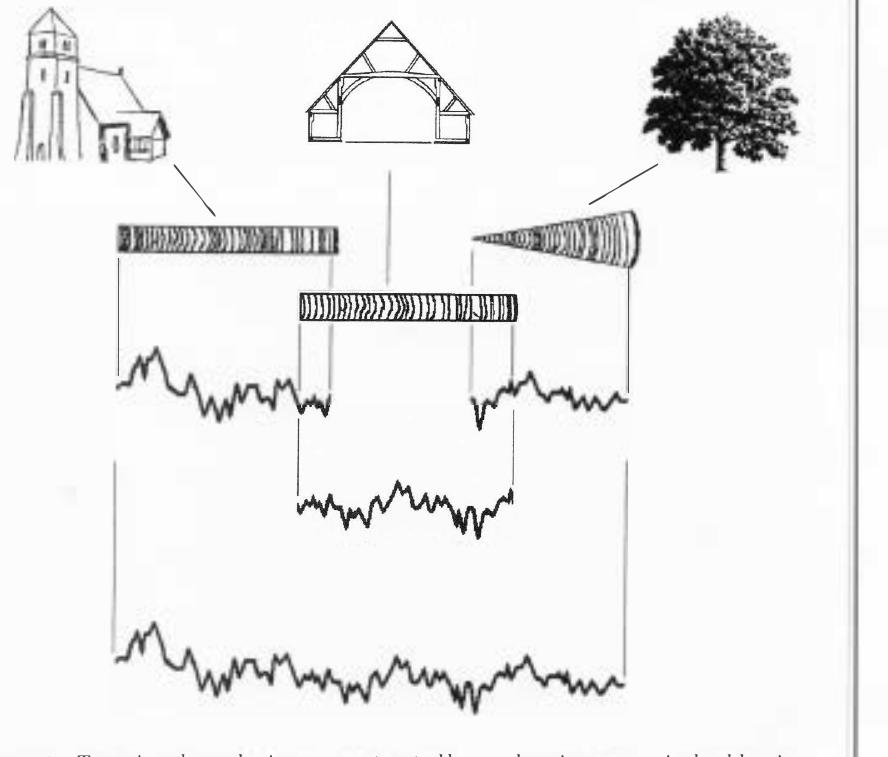
Figure 1 Tree-ring chronologies are constructed by overlapping successively older ring­ width series from a variety of sources. In practice many series may be used for any part of the final